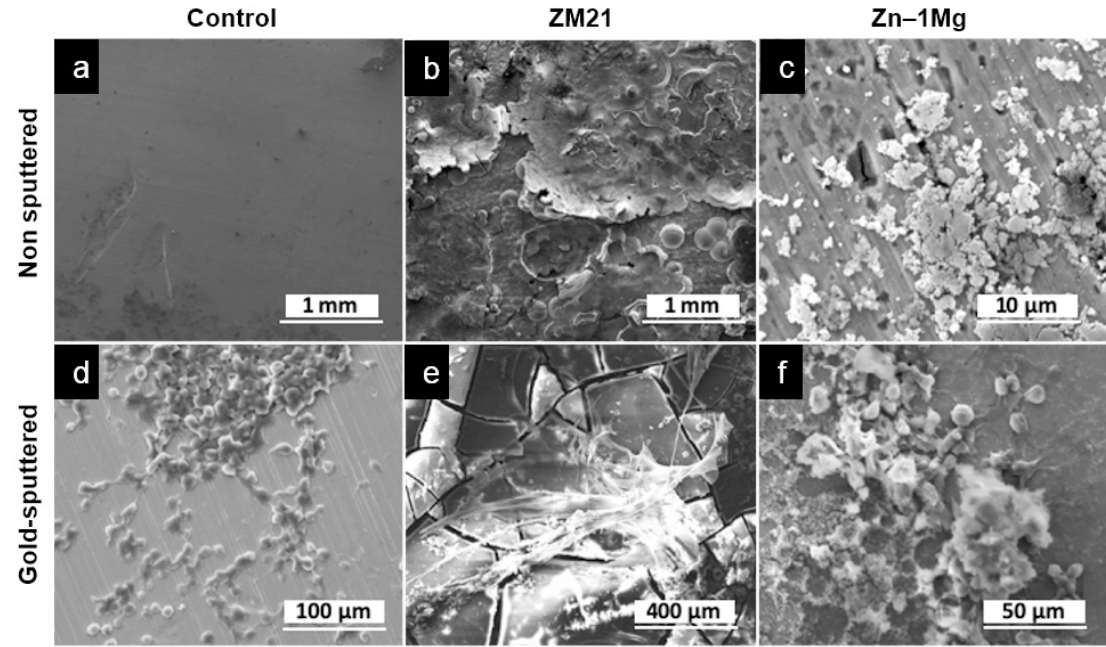
Figure 6. Scanning electron microscope micrographs of the surface of metal disks incubated for 7 days on the UW model: ( a – c ) corrosion layer was observed on the alloys’ surface, while the control showed no change, ( d – f ), urothelial cells and stroma collagen layer attachments were observed on the surface of each disk.